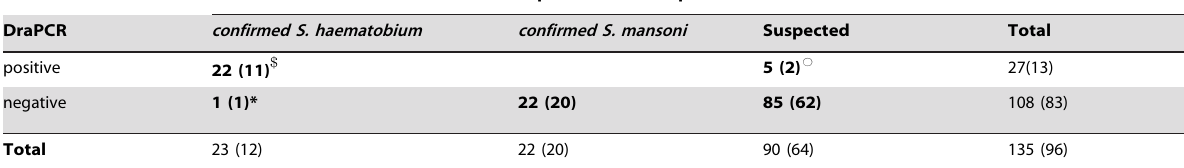
Table 4. Evaluation of the draPCR on